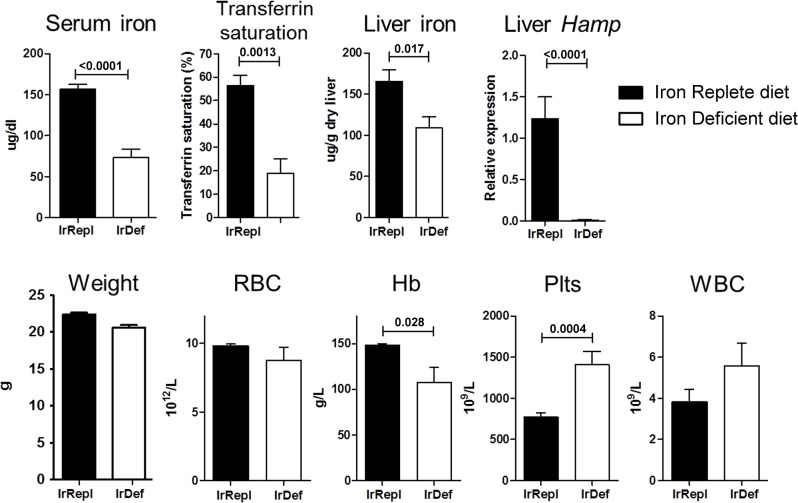
Iron and haematological parameters in mice fed with an iron-deficient diet.Mice were fed for 3 weeks with an iron deficient (IrDef) or iron replete (IrRepl) diet. Bar plots display mean and SEM. Abbreviations: RBC (red blood cells), Hb (Hemoglobin), Plts (platelets), WBC (white blood cells).